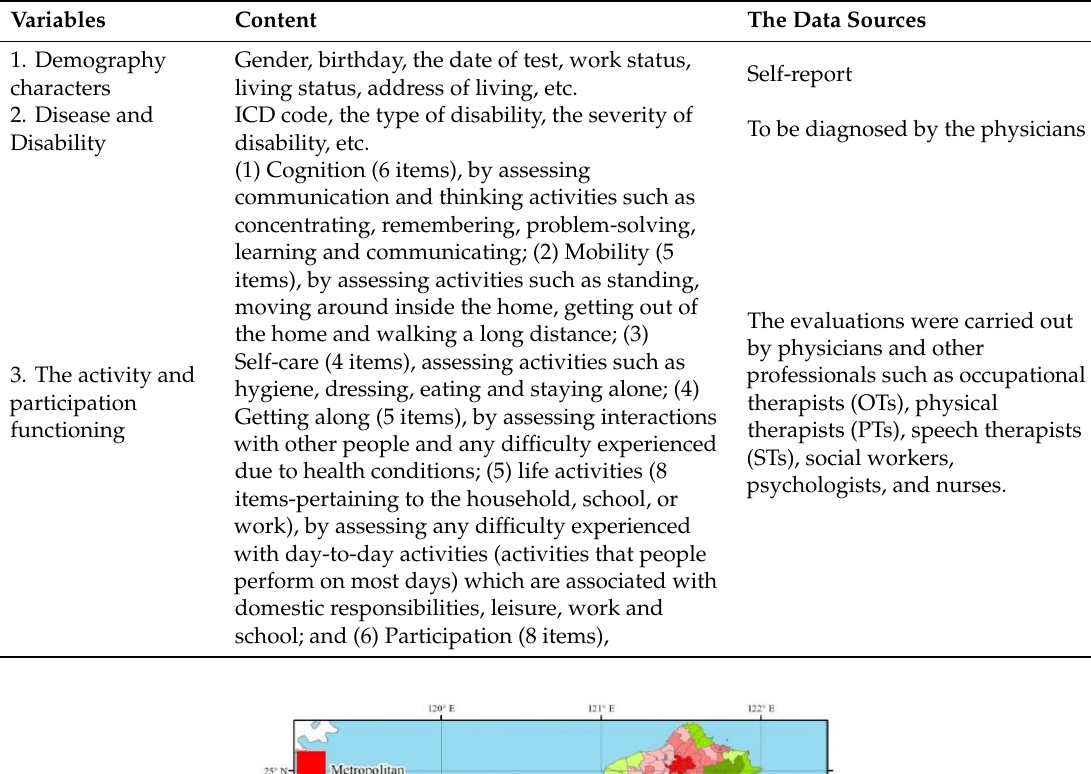
Table 1. The variables and content of the questionnaire in our measurement.